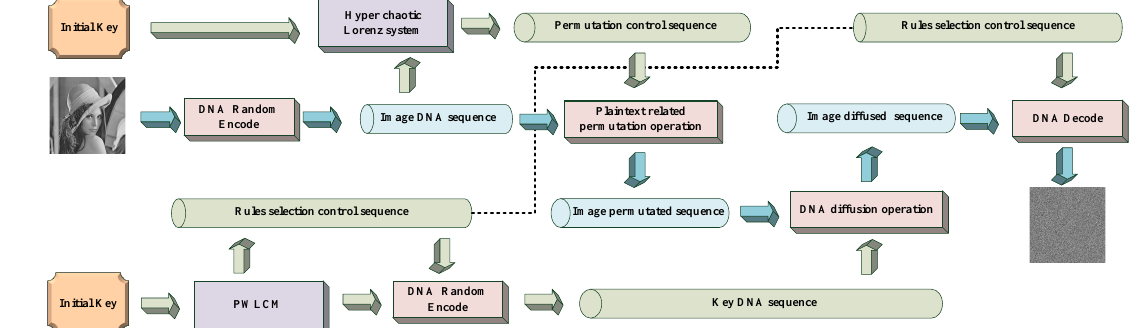
Figure 2. The block diagram of the encryption